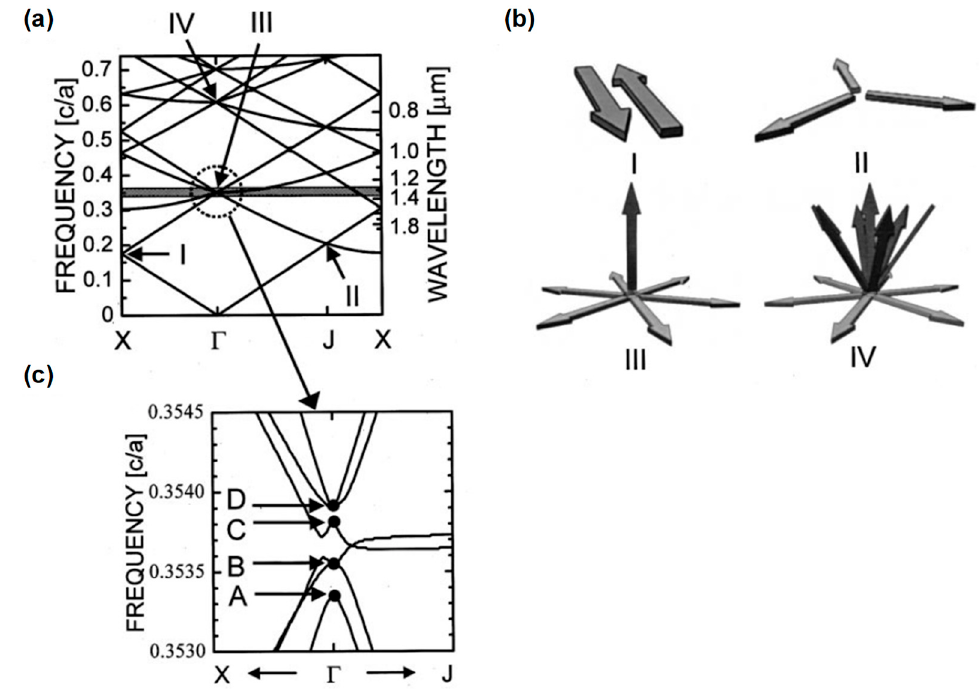
Figure 2. ( a ) Photonic band diagram (dispersion characteristics) of triangular-lattice 2D photonic crystals. ( b ) Coupling states of fundamental waves at band edges I–IV. ( c ) Enlarged view of the band structure at the lowest Γ -point (III). Reprinted figure with permission from [3], copyright 2002 by the American Physical Society.